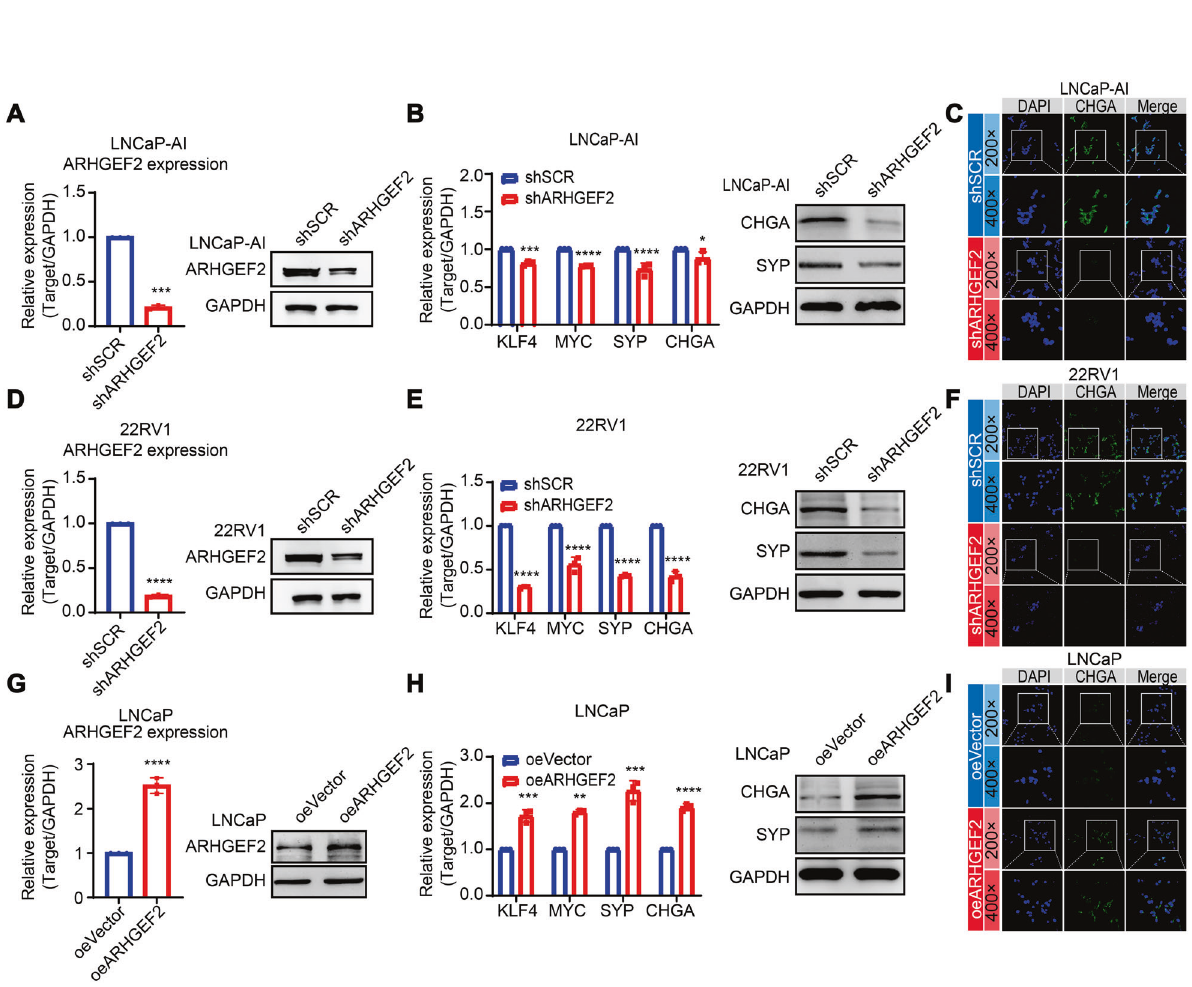
Fig. 4 ARHGEF2 promotes the neuroendocrine differentiation in prostate cancer. A QPCR and Immunoblot data showing ARHGEF2 expression levels in ARHGEF2-silenced (shARHGEF2) and control (shSCR) LNCaP-AI cells. B QPCR data showing relative expression of KLF4, MYC, SYP and CHGA using same cells as A . Immunoblot data showing SYP and CHGA expression using same cells as A . C Immunostaining for CHGA in ARHGEF2-silenced (shARHGEF2) and control (shSCR) LNCaP-AI cells. D QPCR and Immunoblot data showing ARHGEF2 expression levels in ARHGEF2-silenced (shARHGEF2) and control (shSCR) 22RV1 cells. E QPCR data showing relative expression of KLF4, MYC, SYP and CHGA using same cells as D ; Immunoblot data showing SYP and CHGA expression using same cells as D . F Immunostaining for CHGA in ARHGEF2-silenced (shARHGEF2) and control (shSCR) 22RV1 cells. G QPCR and Immunoblot data showing ARHGEF2 expression levels in ARHGEF2-overexpressed (oeARHGEF2) and control (oeVector) LNCaP cells. H QPCR data showing relative expression of KLF4, MYC, SYP and CHGA using same cells as G . Immunoblot data showing SYP and CHGA expression using same cells as G . I Immunostaining for CHGA using same cells as G . For panels A , D , G two-tailed unpaired Student ’ s t-test; B , H , I two-way ANOVA, Sidak ’ s multiple-comparisons test was applied. * P ≤ 0.05, ** P ≤ 0.01, *** P ≤ 0.001, and **** P <